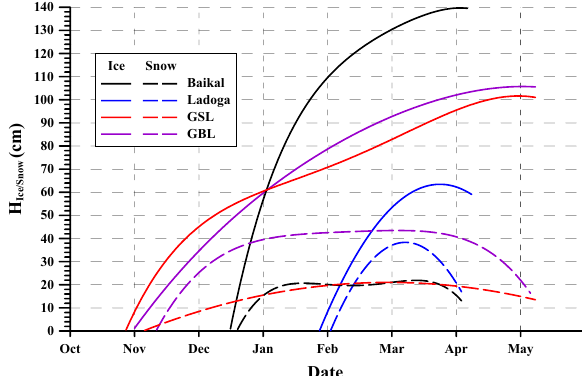
Figure 2. Seasonal variations of air temperature in the study re- gions.